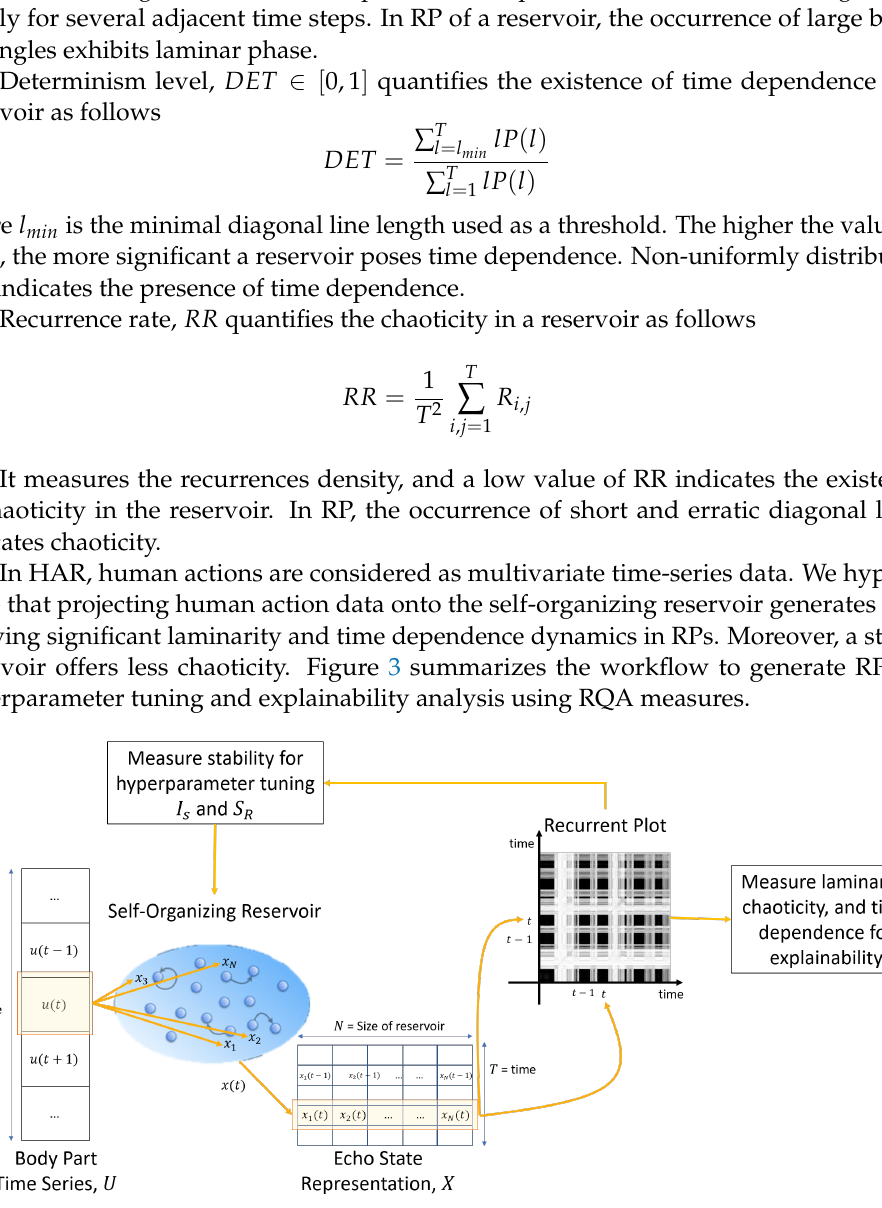
Figure 3. Generating RP for hyperparameter tuning and explainability analysis using RQA measure. u ( t ) is the action input at instant t . Projecting u ( t ) onto the self-organizing reservoir with N neurons generates an echo state x ( t )